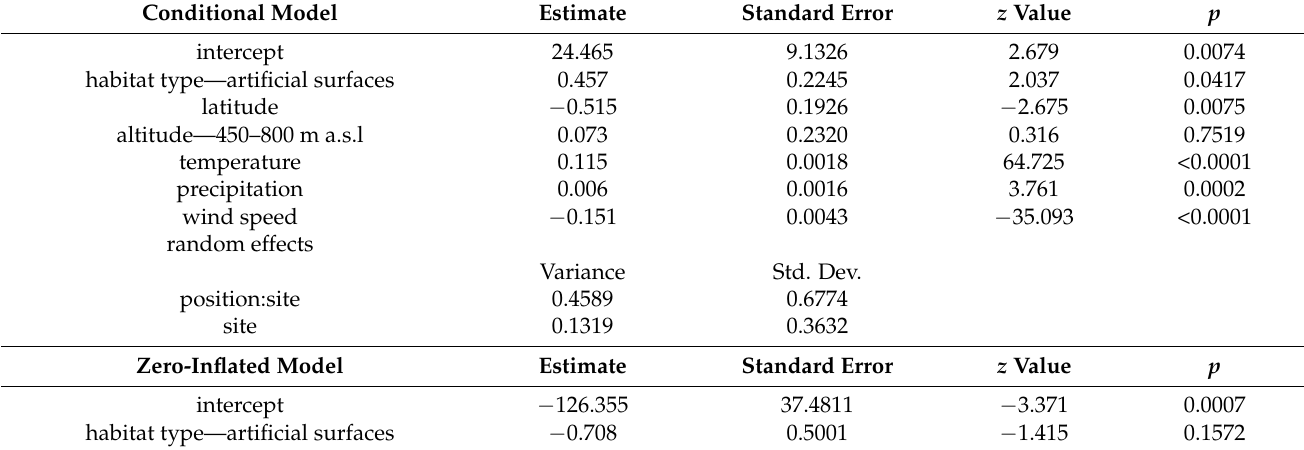
Figure 3. Points and bold lines show the effects of the investigated parameters ( a ) habitat type, ( b ) latitude, ( c ) mean daily temperature, ( d ) daily sum of precipitation and ( e ) daily maximum wind speed on the number of Ae. japonicus eggs as predicted by the generalized linear mixed model for count data, error bars and thin lines represent 95% CI. Conditions for non-focus parameters are set to: habitat type—artificial surfaces, latitude—47.5°N, altitude—100–450 m a.s.l., temperature—20 °C, precipitation—0 mm, max. wind speed—8 km/h. Table 1. Model results analyzing the variables influencing the number of Ae. japonicus eggs using a zero-inflated generalized linear mixed model, taking into account the different observation periods. Note that this model has two parts, a Poisson count model (conditional model) and the logit model for predicting excess zeros. Number of observations: 4258, within 219 groups position:site and 43 groups within factor site.